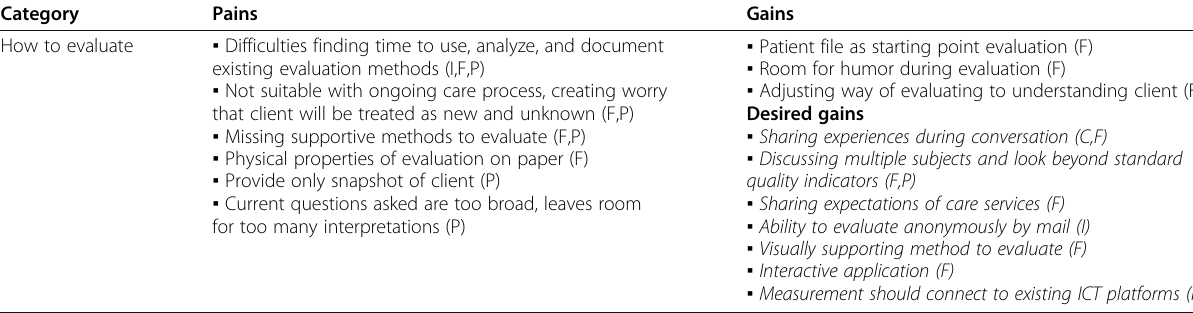
Table 5 Identified pains and (desired) gains for ‘ how to evaluate ’ Category Pains Gains How to